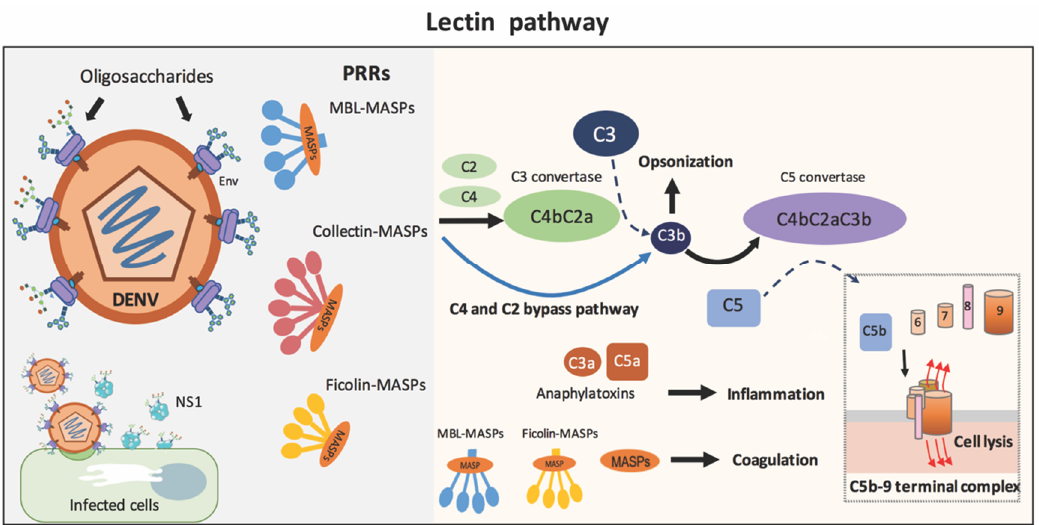
Figure 1. Lectin pathway. Initiation of the lectin pathway (LP) results from the binding of pathogen recognition receptors (PRRs) on microbial carbohydrates, as represented in mature dengue virus. The PRRs (MBL, ficolin, or collectin) assemble with MBL- associated serine proteases (MASP-1 and MASP-2) to activate complement C3 through (1) the actions of C4 and C2 to produce C3 convertase (C4bC2a) or (2) the C4 and C2 bypass pathway. C3b fragments activate further down the cascade to generate C5b-9 complexes on the microbial surface or promote opsonization. C3a and C5a are anaphylatoxins. Additionally, PRR-MASP complexes or MASPs alone are involved in coagulation. Note that the AP can substantially amplify the complement activation from C3b initially generated by the LP.